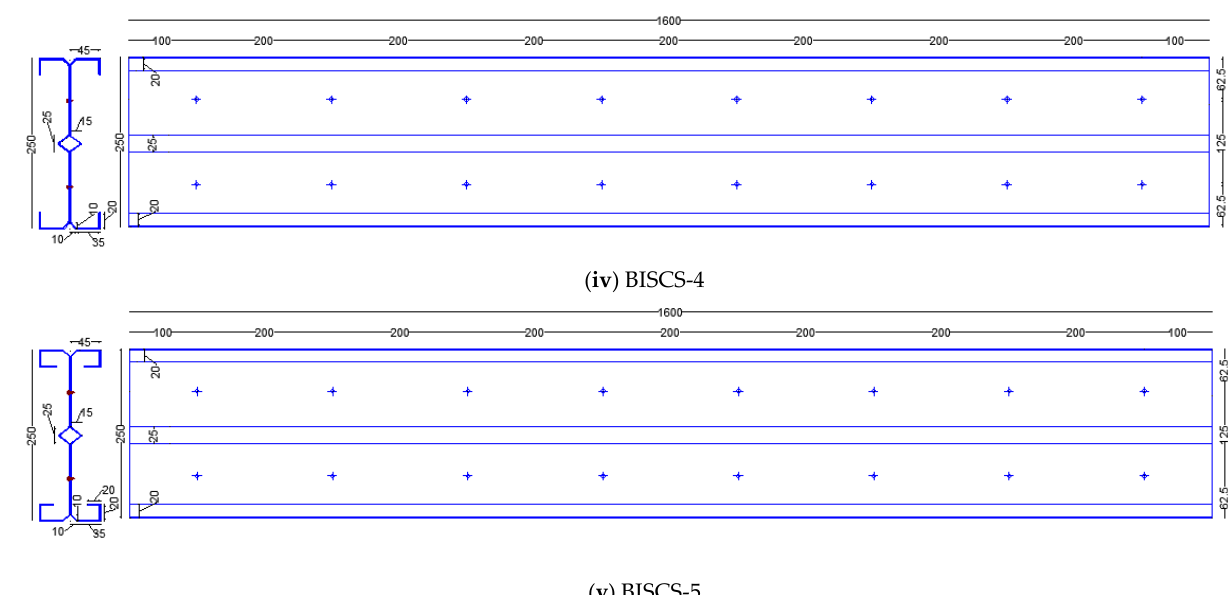
Figure 4. Geometrical details of back-to-back intermediately stiffened channel sections (BISCS). (All the dimensions are in mm).